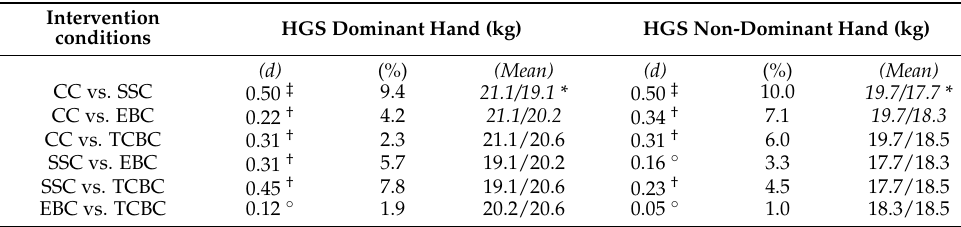
Table 2. Differences between intervention conditions on handgrip strength in physically inactive older females.